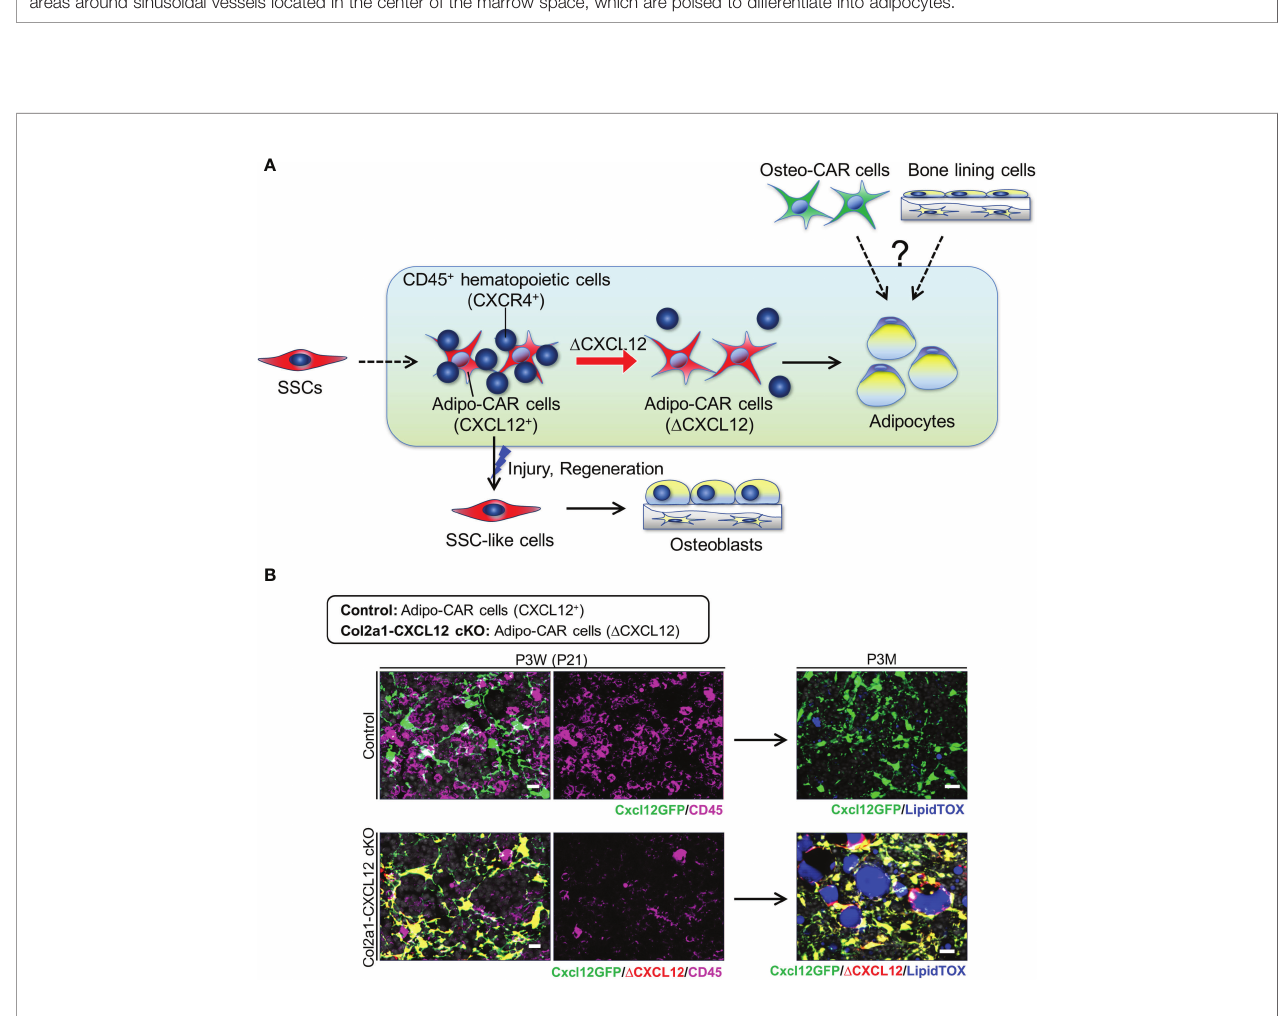
FIGURE 2 | Adipogenic trajectory of the bone marrow stromal cell lineage. (A) In physiological condition, dormant Adipo-CAR cells can become marrow adipocytes. Hematopoietic cells may regulate marrow adipogenesis in a manner dependent on CXCL 12-mediated physical coupling. CXCL 12 deletion leads to a reduction of stromal-hematopoietic coupling and accelerates marrow adipogenesis. In contrast, Adipo-CAR cells convert into skeletal stem cell-like cells in response to injury, and redifferentiate into osteoblasts through cellular plasticity to support cortical bone regeneration. (B) Central bone marrow of control ( Cxcl12 GFP/+ ) and Col2a1-CXCL12 cKO ( Col2a1-cre; Cxcl12 GFP/ fl ) mice stained for CD45 and lipid TOX, at 3W (left) and 3M